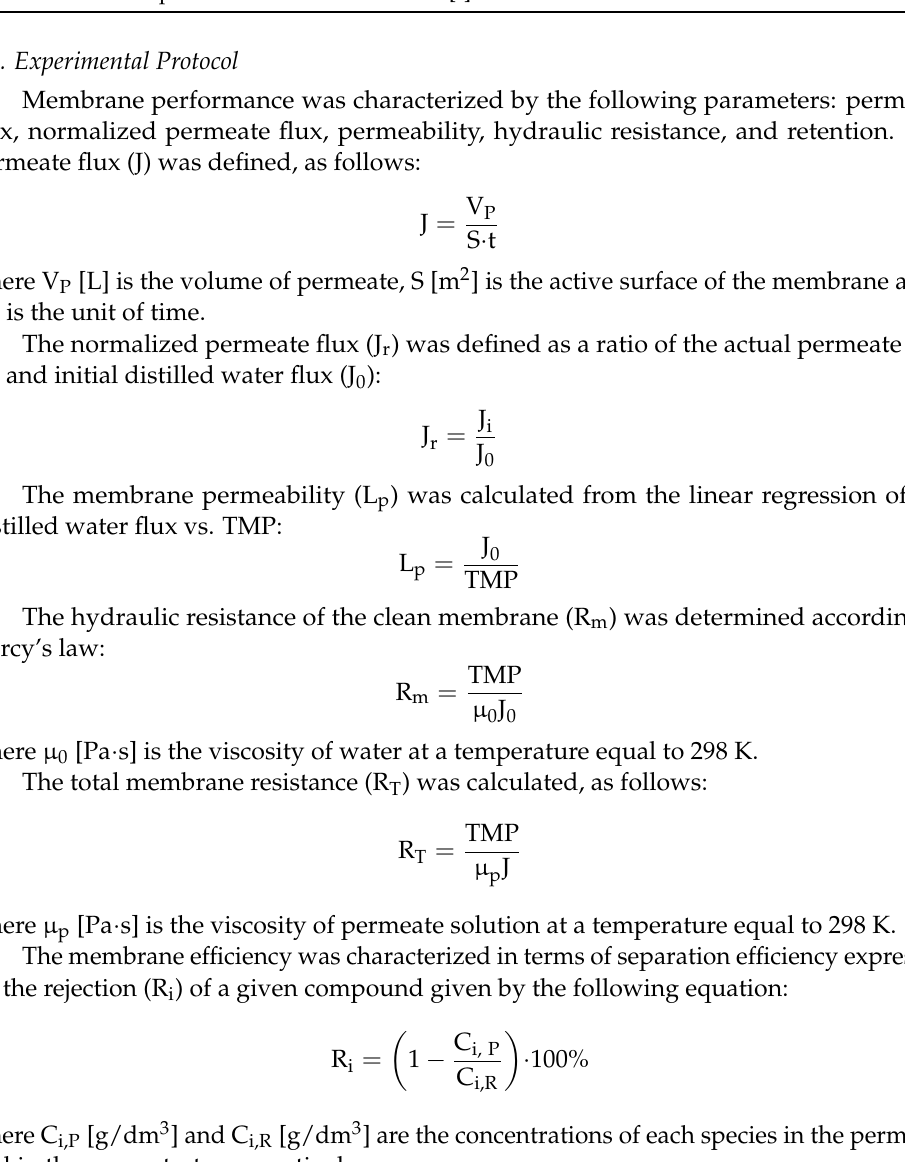
Table 2. Main characteristics of the NF membrane used in the present work. Parameter Unit Value Manufacturer [-] DOW-Filmtec Skin-layer material [-] polyamide Molecular weight cut-off [Da] 200–300 Average pore radius [nm] 0.43 MgSO 4 rejection [%] 97 NaCl rejection [%] 50 Contact angle [ ◦ ] 54.8 Maximal pressure [MPa] 4.1 Maximal temperature [ ◦ C] 45 pH range [-] 2–11 Isoelectric point [-]